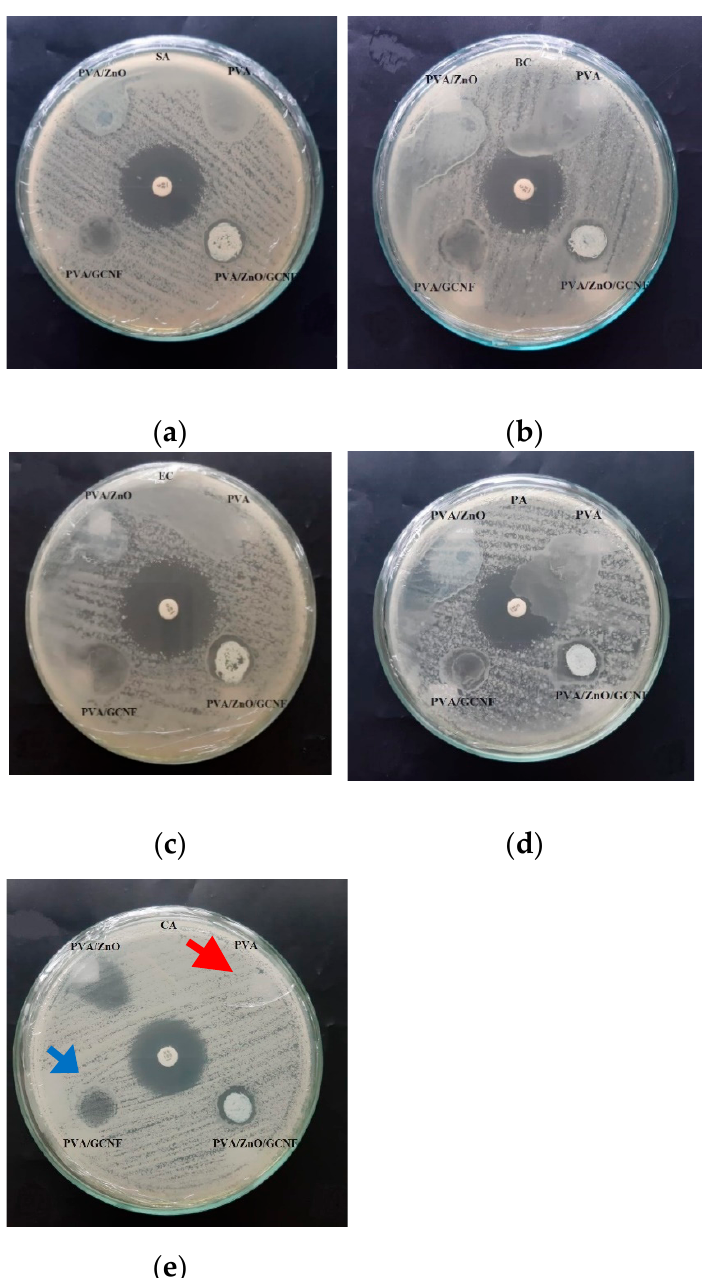
Figure 6. Antimicrobial activity of PVA and biocomposite film against gram-positive SA ( a ), BS ( b ), PA ( c ), EC ( d ), and CA ( e ). The more transparent area (blue and red arrows) is the inhibition zone diameter. Table 4. Antimicrobial properties of each sample.